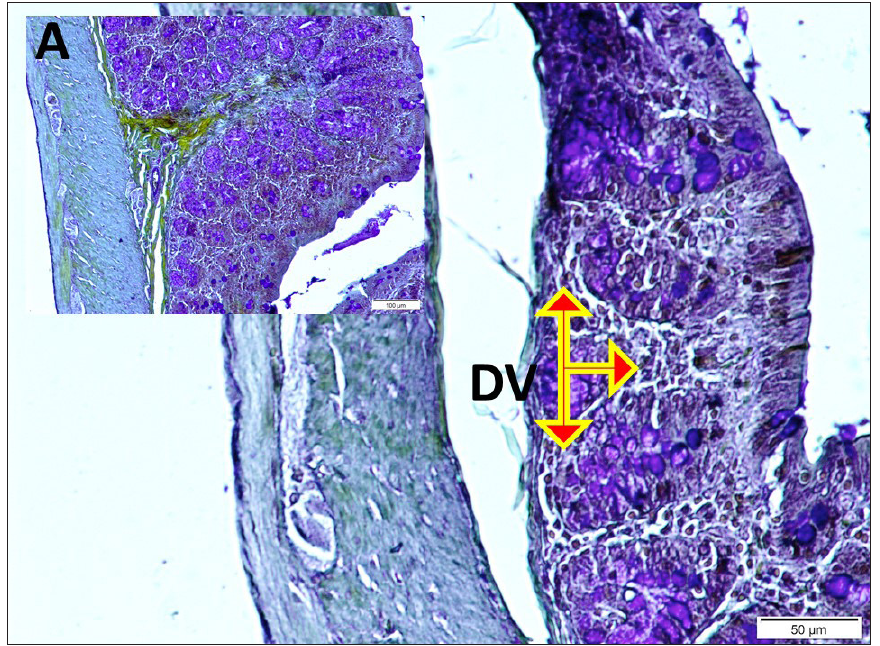
Figure 4. Histological view of the normal intestinal villi (NV) (LM, Aldehyde Fuchsin, x10/A) and degenerated epithelial cells and villi (Dv/LM, Aldehyde Fuchsin, x20/Base) of a study